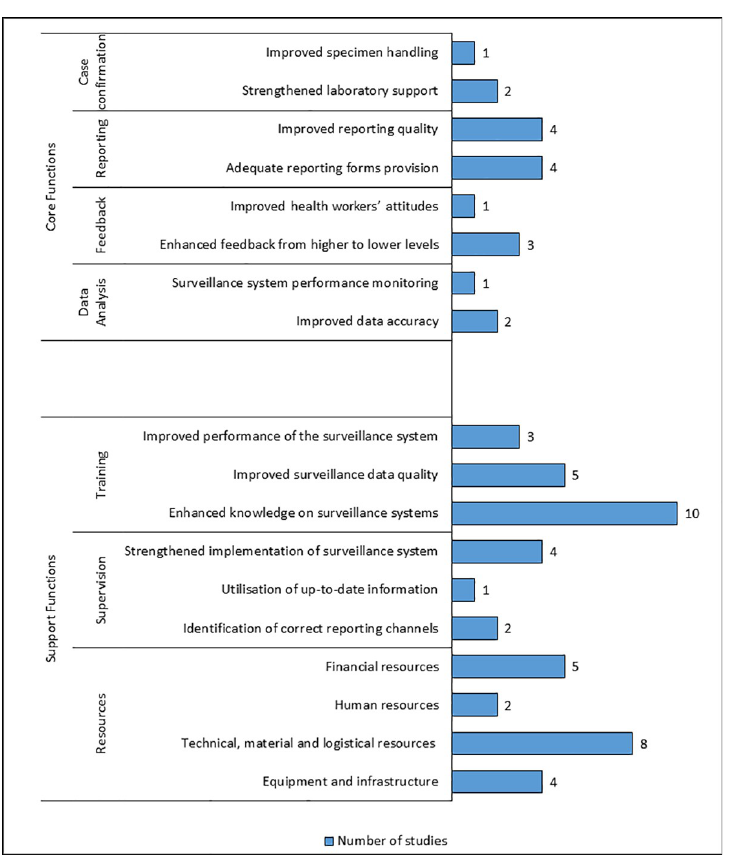
Fig 2. Summary of themes, sub-themes and the number of reviewed